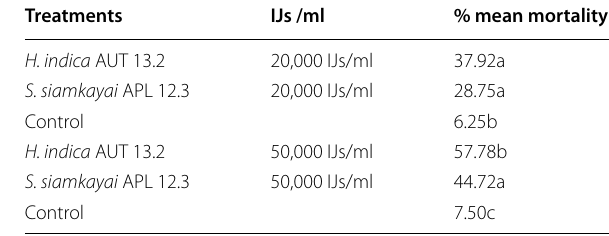
Table 2 Mean of accumulated mortality percentage of the Table 3 The mean of accumulated mortality percentage of the fifth instar larvae of FAW at 10 days after application of the EPNs 2nd instar larvae of FAW at 10 days after application of the EPNs Heterorhabditis indica isolate AUT 13.2 and Steinernema siamkayai Heterorhabditis indica isolate AUT 13.2 and Steinernema siamkayai isolate APL12.3 in the laboratory condition isolate APL12.3 in the greenhouse Larval stage Concentrations EPNs of EPNs (IJs/ml)